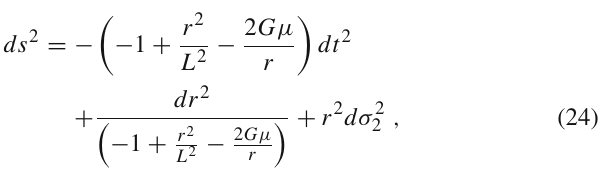
Fig. 4 Left: the threshold curves for AdS black hole with posi- tive curvature where the blue dot represents the threshold value of Schwarzschild black hole; Middle: the scalar hair of the black hole as